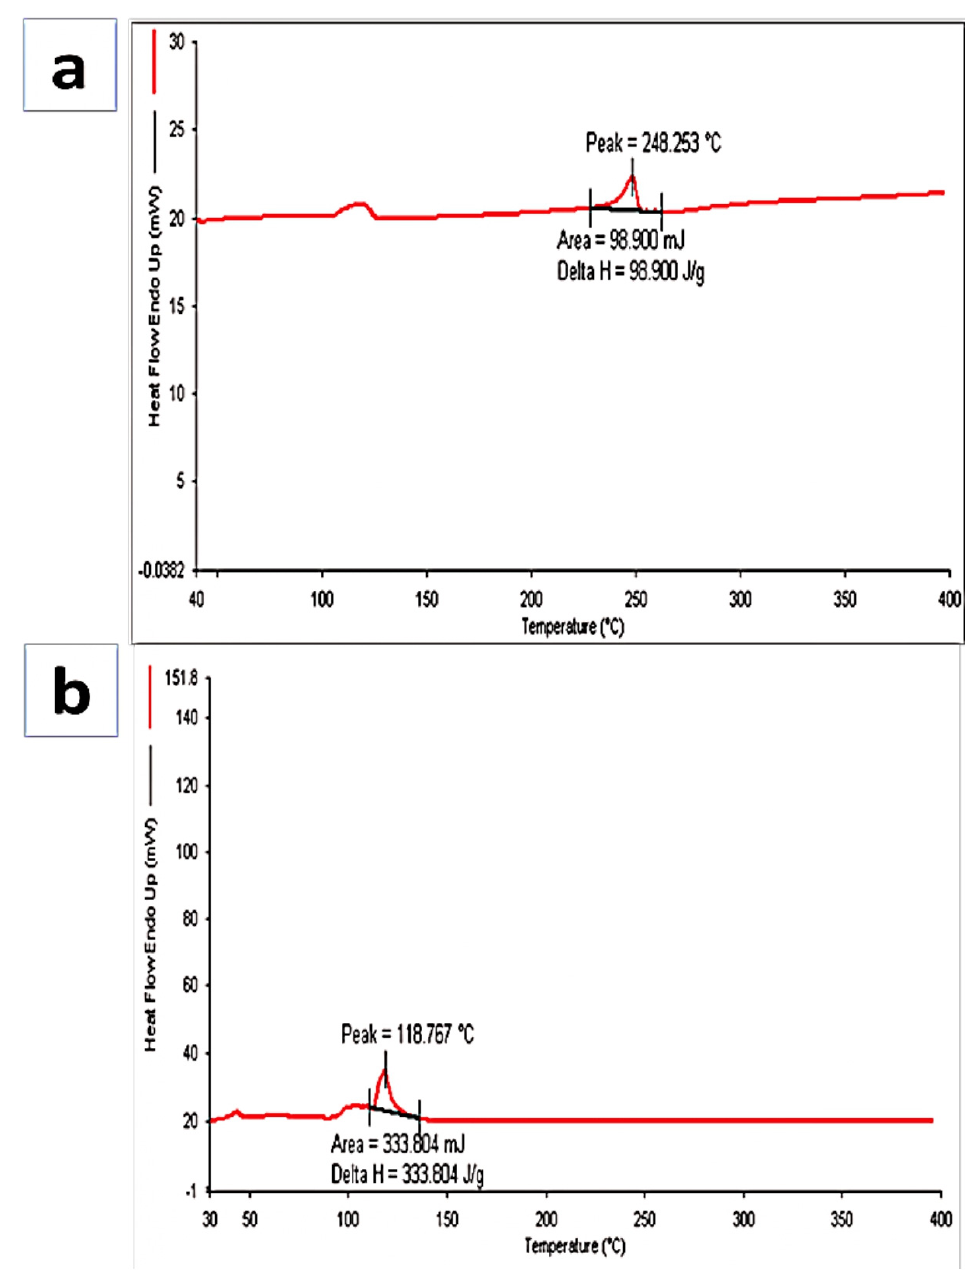
Figure 2. Representation of DSC analysis of ( a ) Hsp and ( b )